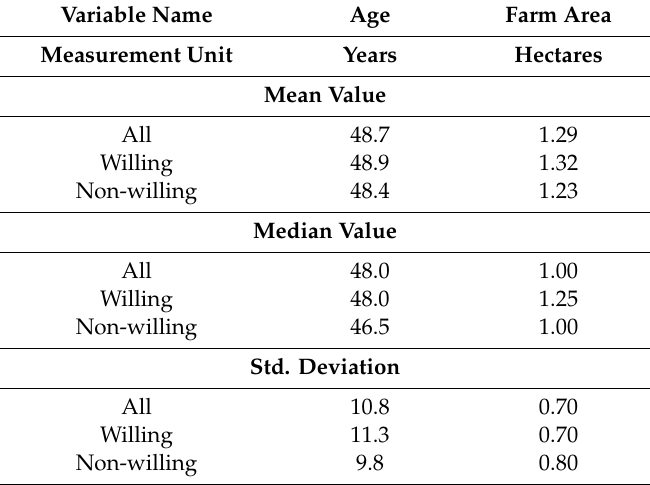
Table 4. Summary of continuous variables used in the logistic regression model.